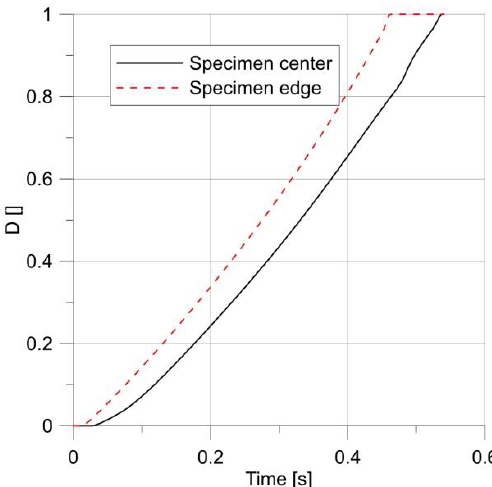
Figure 12. Changes in parameter D over time for a specimen with a notch R = 1.0 mm.